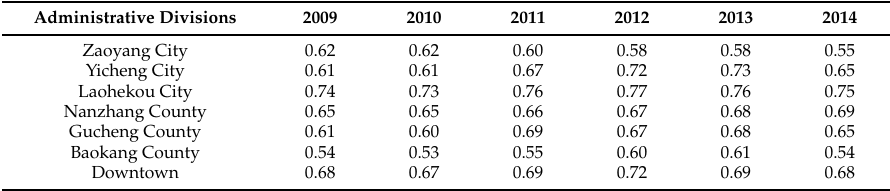
Figure 4. Inter ‐ annual variation curve of SEDI and RLSI. ( a ) RLSI; ( b ) SEDI. The red line is the trend line of RLSI and SEDI, respectively. Table 3. Calculation results of RLSI from 2009 to 2014 in Xiangyang City.